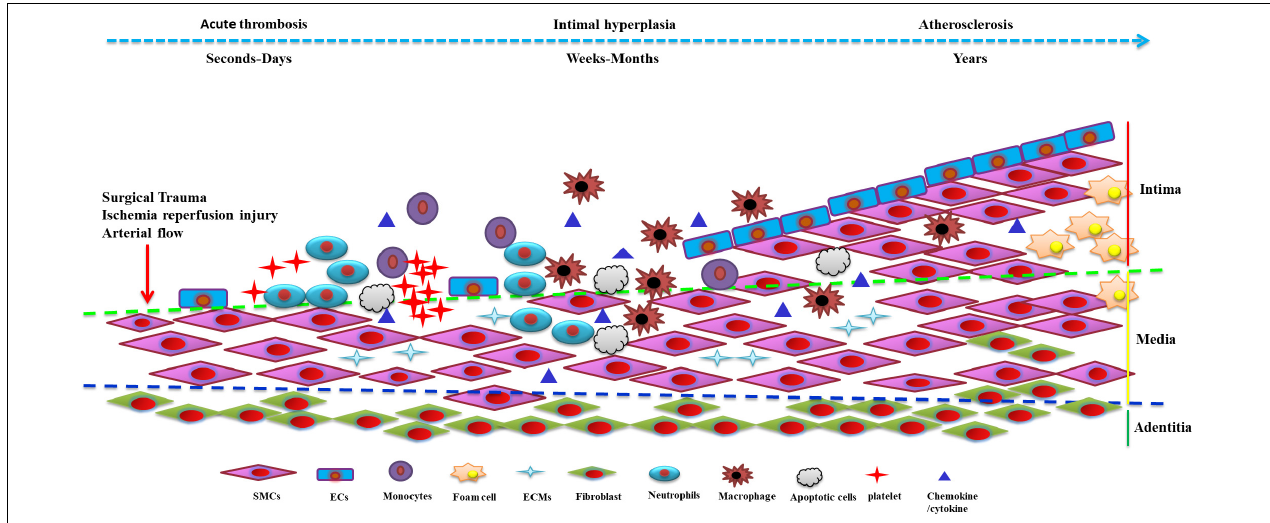
FIGURE 1 | The phenotype of venous smooth muscle cells (SMCs) in the development of vein graft restenosis: Stimulated by various injuries, pathological factors and stress alterations, venous SMCs can transform from a differentiated to a dedifferentiated state, accompanied by a decrease in the expression of the above-mentioned differentiation-specific markers. Venous vascular smooth muscle cells (VSMCs) secrete many extracellular matrix (ECMs) and cytokines, causing excessive proliferation and further migration to the intima leading to intimal hyperplasia resulting in vein graft restenosis. SMCs, smooth muscle cells; ECs, endothelial cells; ECMs, extracellular